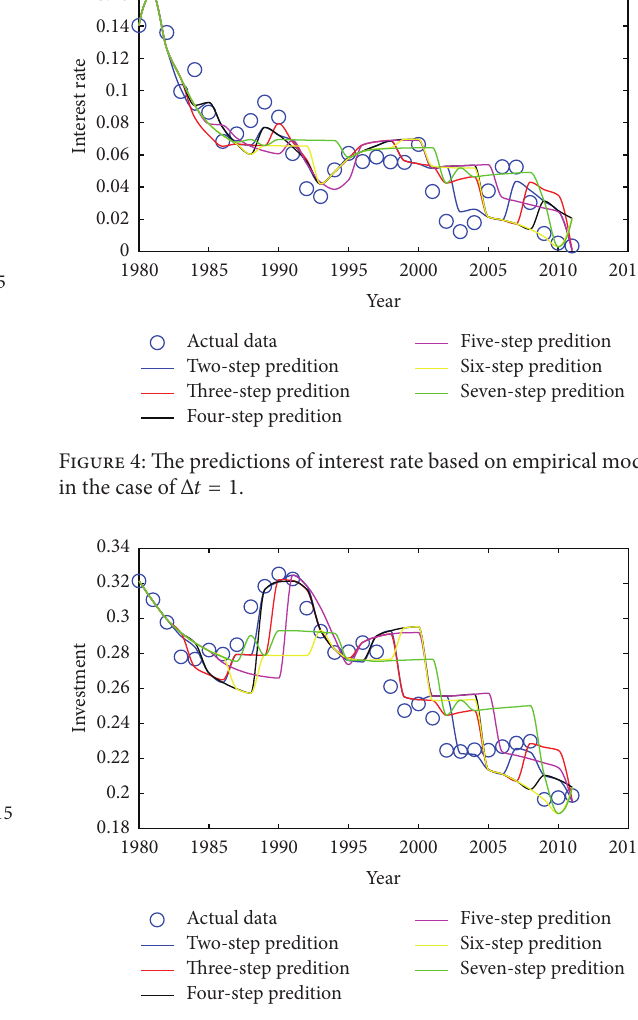
Figure 5: The predictions of investment based empirical model in the case of Δ𝑡 = 1